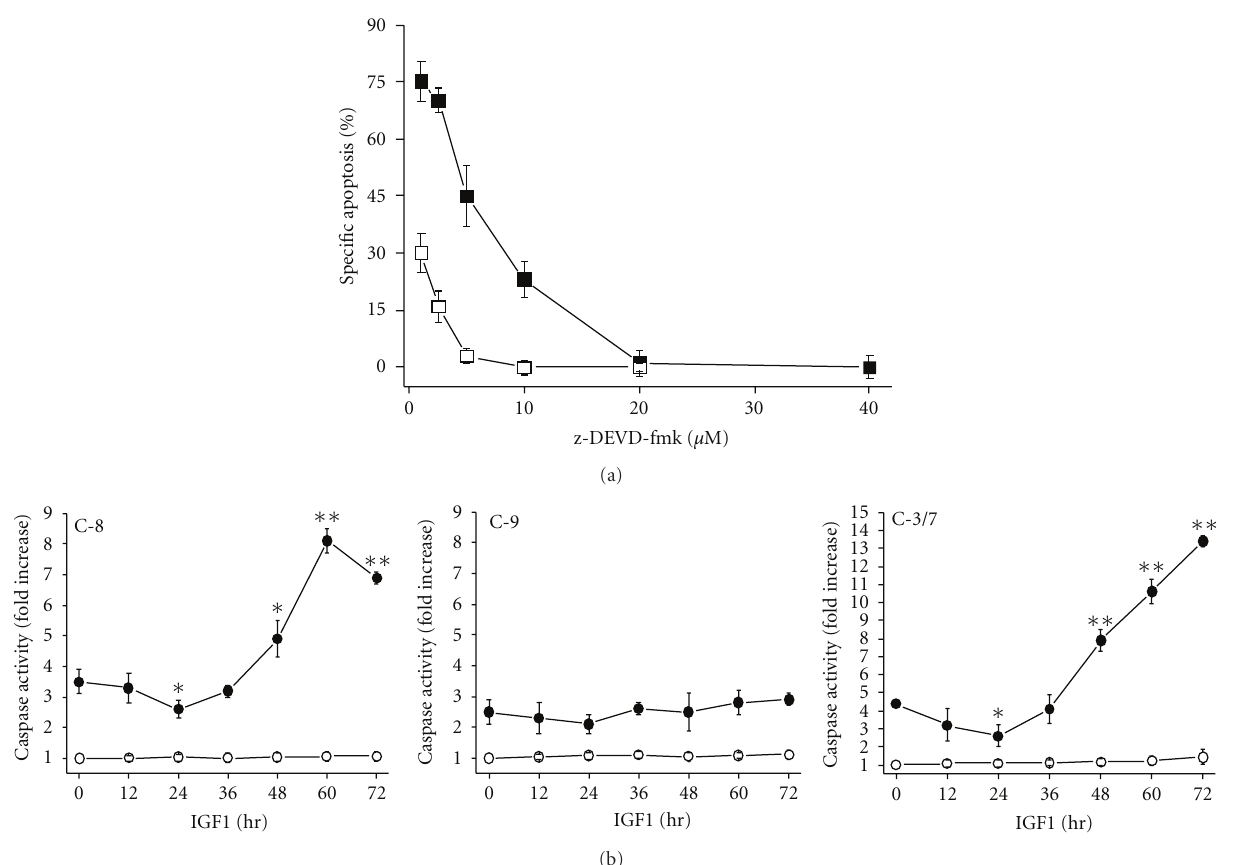
Figure 3: Involvement of caspase-like proteases in Apo2L/TRAIL-induced apoptosis. (a) Percentage-specific apoptosis in VH-64 cells treated for 72 hours in the absence ( (cid:2) ) and presence ( (cid:3) ) of IGF1 (100 ng/mL) and subsequently for 30 min with varying concentrations of z-DEVD- fmk, followed by incubation with Apo2L/TRAIL (50ng/ml; 8 hours). Error bars: mean ± SD of triplicate determinations from 2 independent experiments. (b) Fold increase in the activity of caspase-8 (C-8), caspase-9 (C-9), and caspase-3/7 (C-3/7) in cells treated for the indicated times with IGF1 (100ng/mL), followed by incubation in the absence ( ◦ ) and presence ( • ) of Apo2L/TRAIL (50ng/mL; 4 hours). Values of vehicle-treated controls for caspase-8, caspase-9, and caspase-3/7 activity were set to 1. Asterisks: ∗ P < 0 . 05, ∗∗ P < 0 . 02; error bars: mean ± SD of triplicate determinations from 3 independent